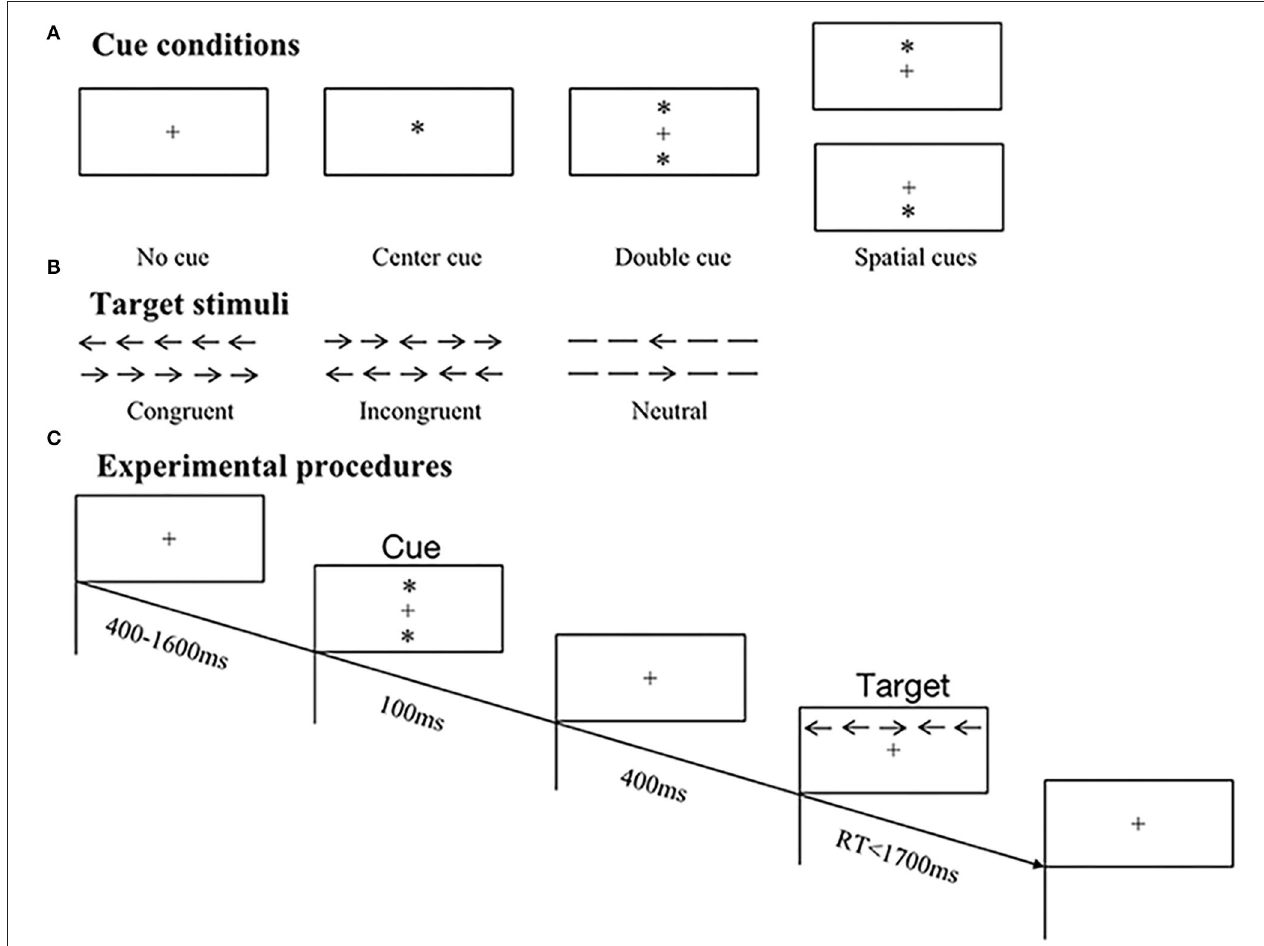
FIGURE 1 | Schematic illustrations of original ANT paradigm. (A) Samples of four cue conditions, including no cue, center cue, double cue, and spatial cues. (B) Samples of three target types, including congruent, incongruent, and neutral stimuli. (C) Experimental procedures of trials in ANT. In this example, a double cue preceded an incongruent target, and the correct response was right button